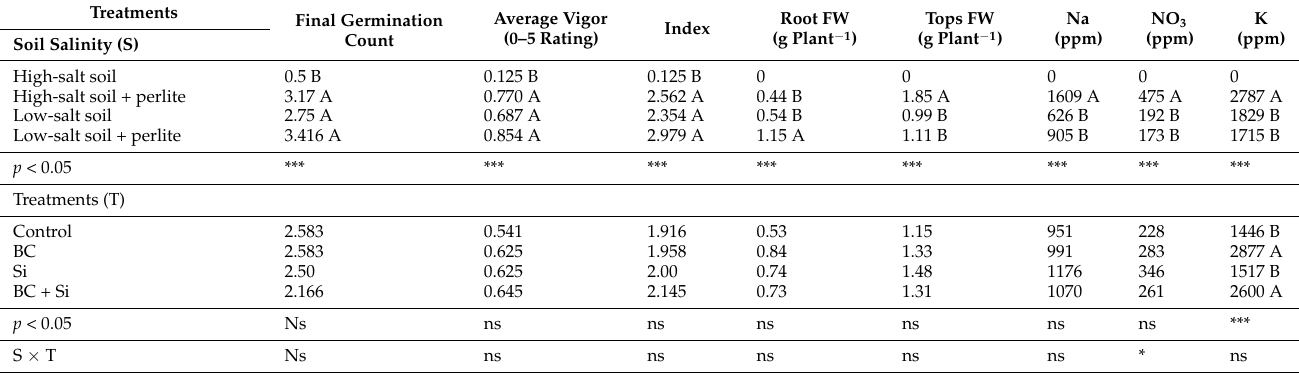
Table 2. Germination, plant vigor, FW, sap nutrient concentration, and significance levels in Experiment